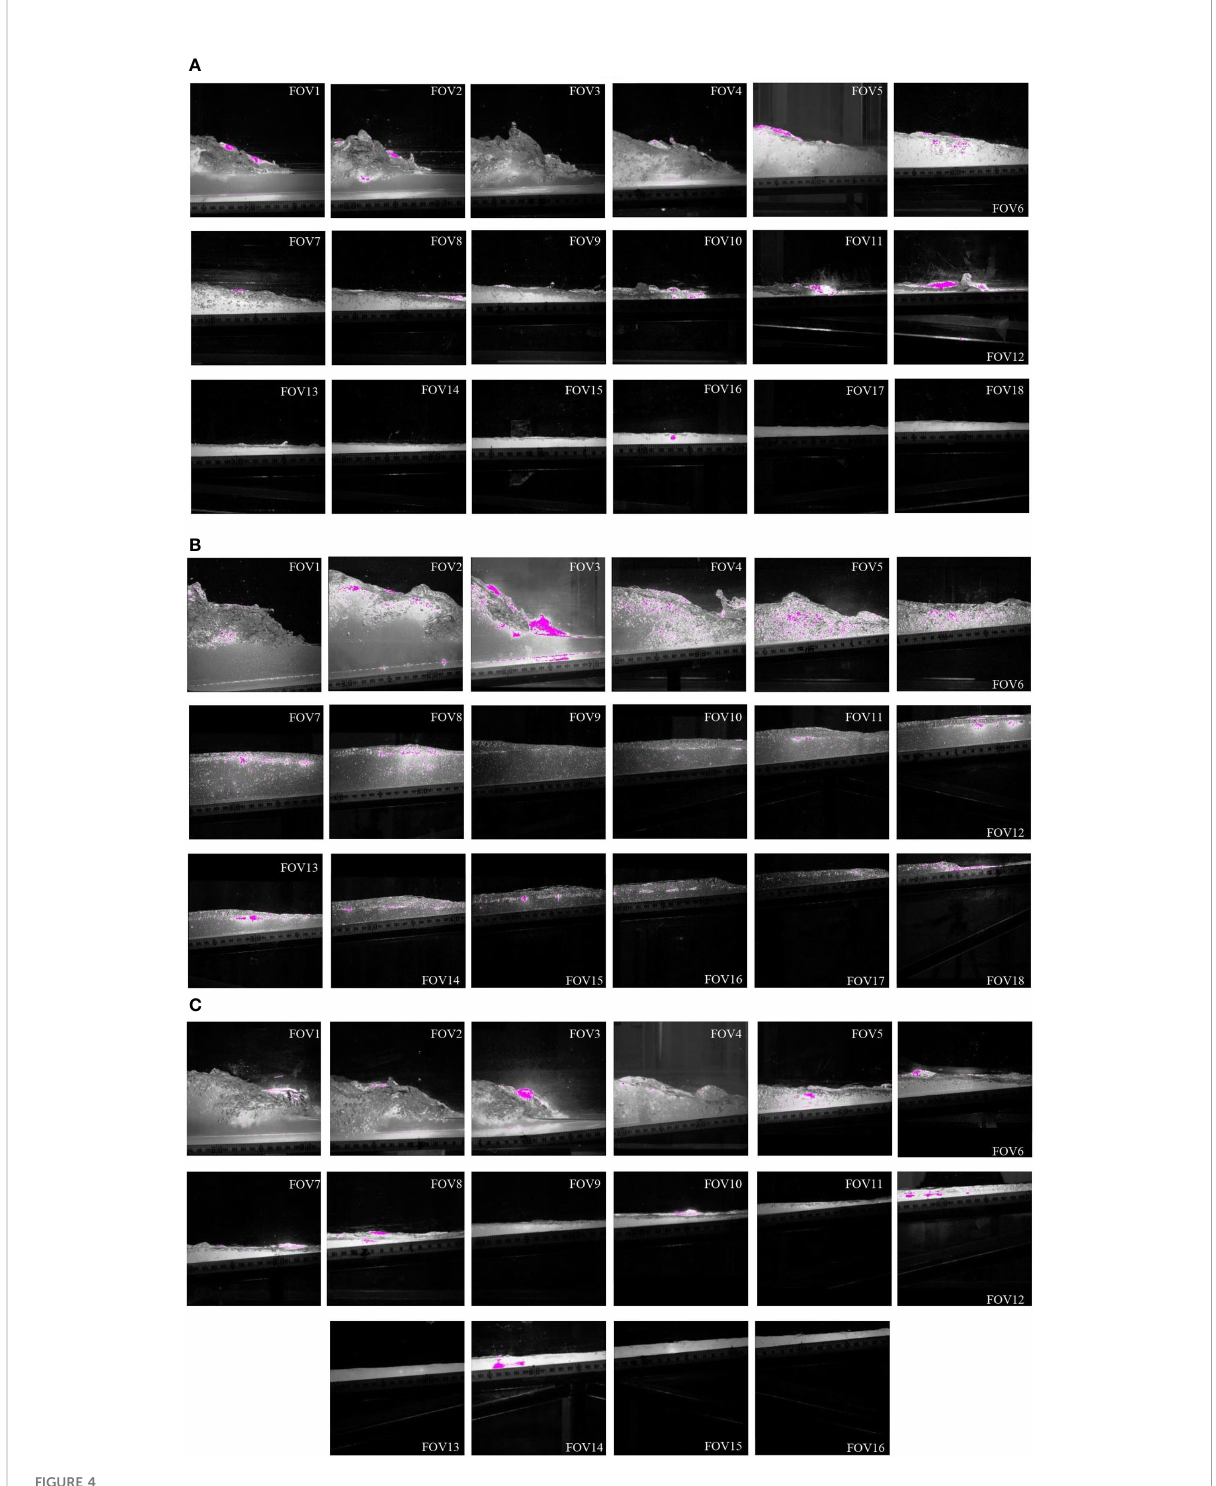
FIGURE 4 The bore evolution in the selected PIV windows (FOV): (A) mild beach; (B) steep beach; (C) composite